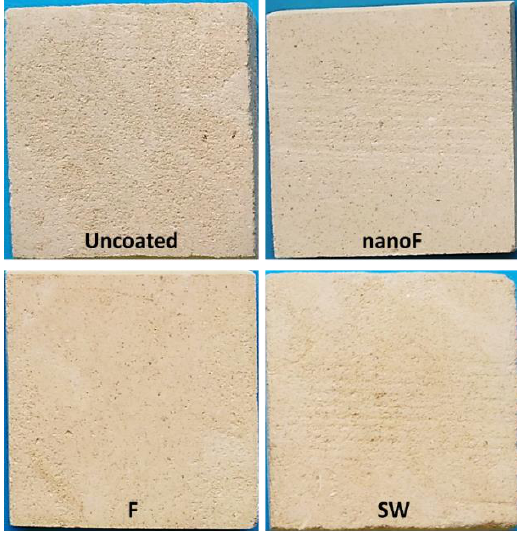
Figure 5. Uncoated and coated PS stone surfaces.